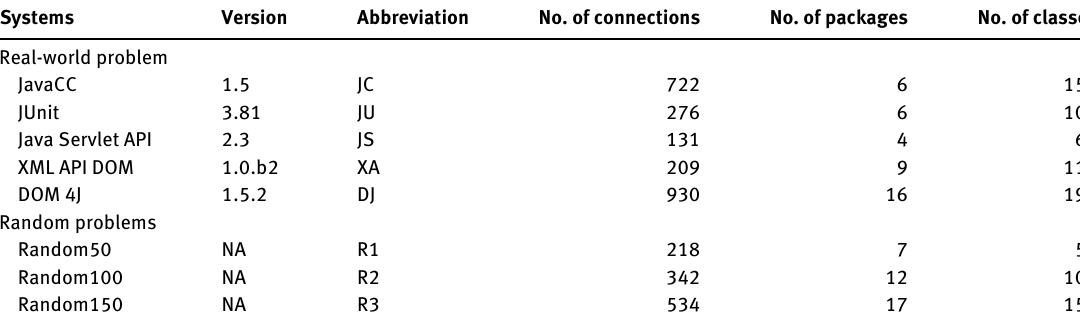
Table 1: Characteristics of Software